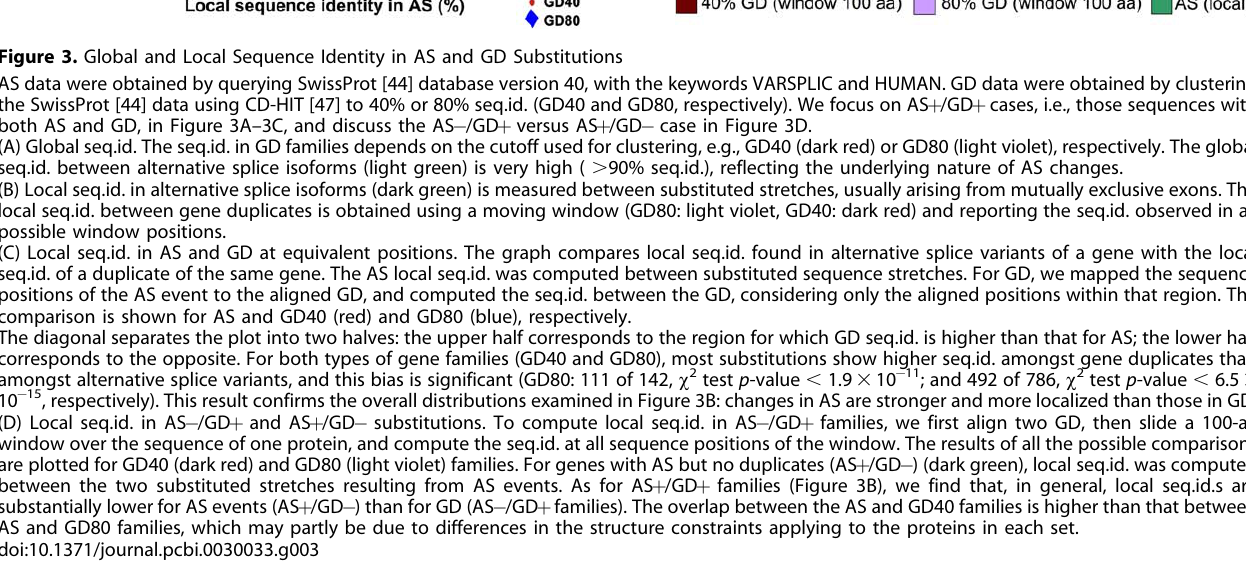
both, are known to exist (AS þ /GD– and AS–/GD þ , Figure 3D).